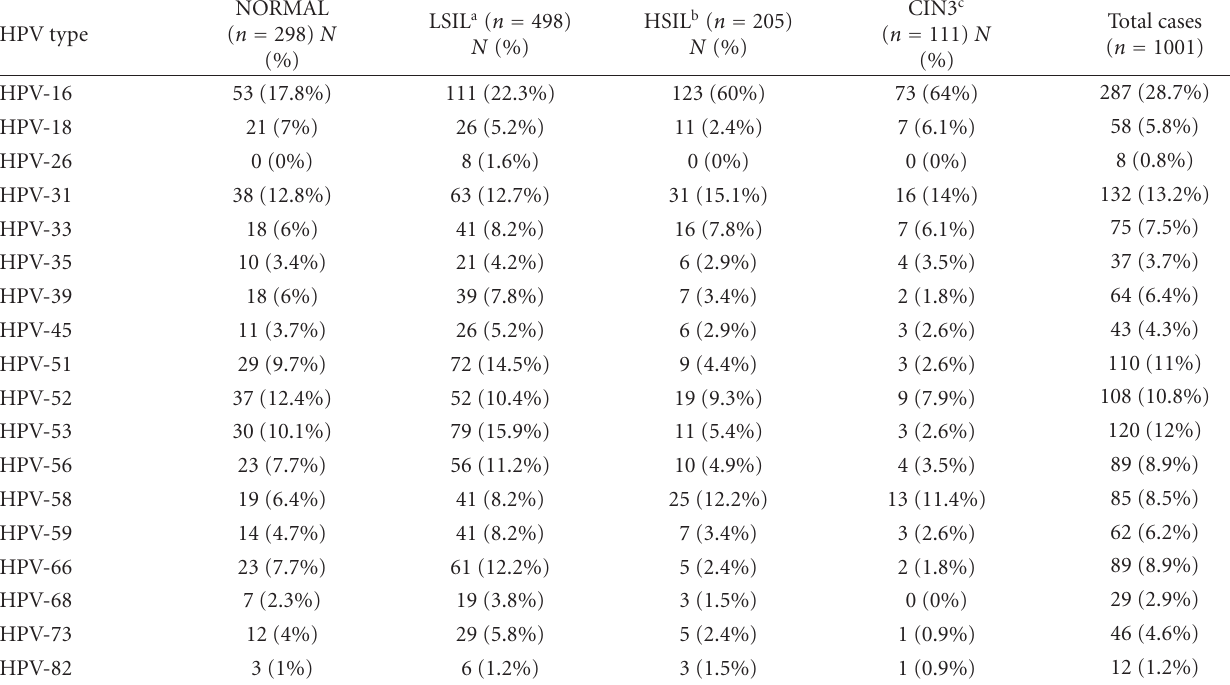
Table 2: Distribution of HR-HPV types by histological and cytological